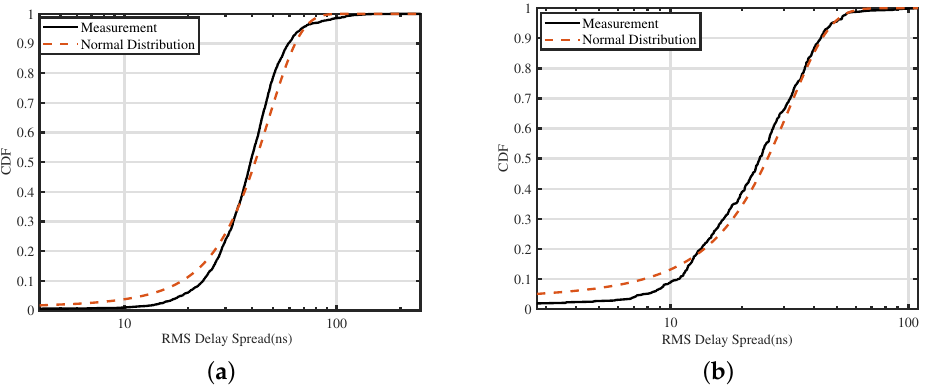
Figure 9. CDF of RMS delay spread values for Op1 and Op2 at measurement location 1. ( a ) Op1 with best fit distribution ∼N ( 44, 24 ) . ( b ) Op2 with best fit distribution ∼N ( 26, 13 ) . Table 4. Mean and standard deviation values of RMS delay spread for Op1 and